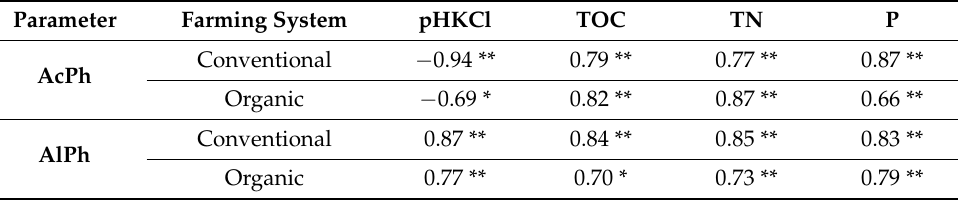
Table 12. Significant correlation coefficients between the activity of the examined enzymes and pH KCl and the content of organic carbon (TOC), total nitrogen (TN) and available phosphorus (P) form. Parameter Farming System pHKCl TOC TN P Conventional − 0.94 ** 0.79 ** 0.77 ** 0.87 ** AcPh Organic − 0.69 * 0.82 ** 0.87 ** 0.66 ** Conventional 0.87 ** 0.84 ** 0.85 ** 0.83 ** AlPh Organic 0.77 ** 0.70 * 0.73 ** 0.79